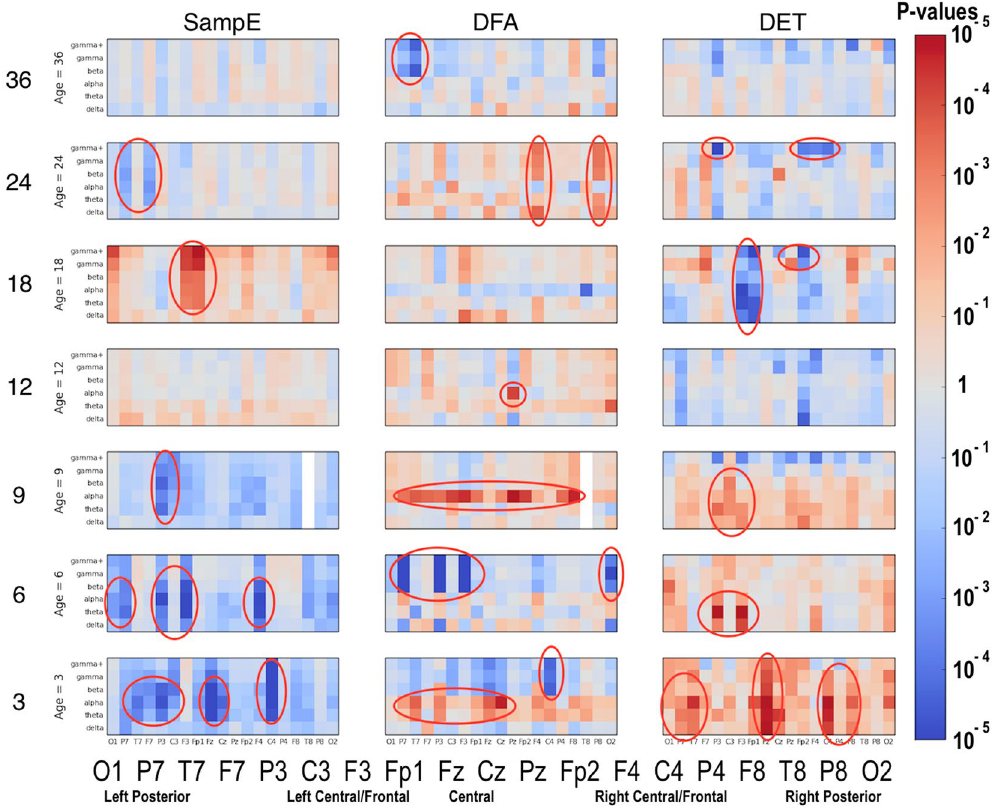
Figure 5. Differences between ASD and LRC − group values for SampE, DFA, and DET are shown using color for every nonlinear value. The vertical axis for each subplot represents six frequency bands, from low (delta) to high (gamma + ), as defined in Table 2. The horizontal axis for each subplot is the scalp location. The axis labels are shown in a single large horizontal label across the bottom of the plot. The left or right side of each subplot corresponds to left or right sensors, respectively. Centrally located sensor values are in the center of the subplots. Red colors indicate that the values for this feature are higher in the ASD group. Blue colors indicate that ASD values are lower for that feature. Color saturation (darker red or darker blue) is correlated to the significance of the group differences. The scale on the right of the figure shows p-values of the color saturation. White areas with washed-out color indicate p-values close to 1.0, hence no significant